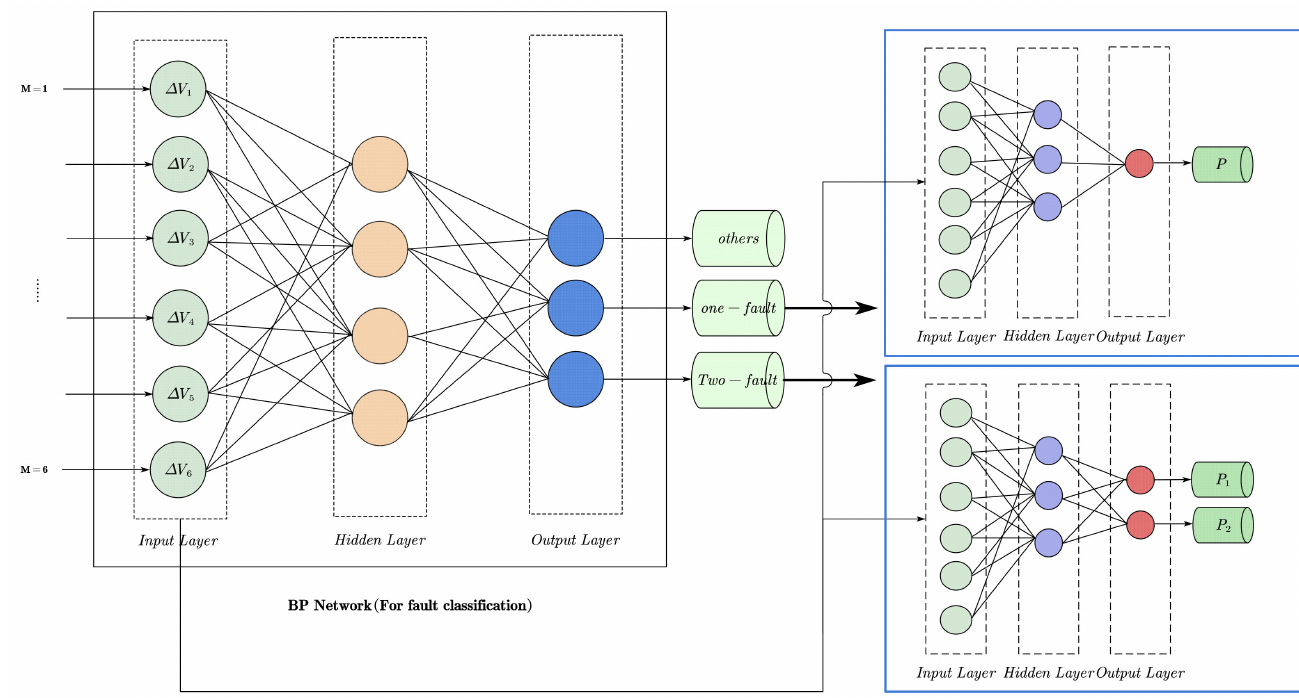
Figure 9. BP Neural network structure